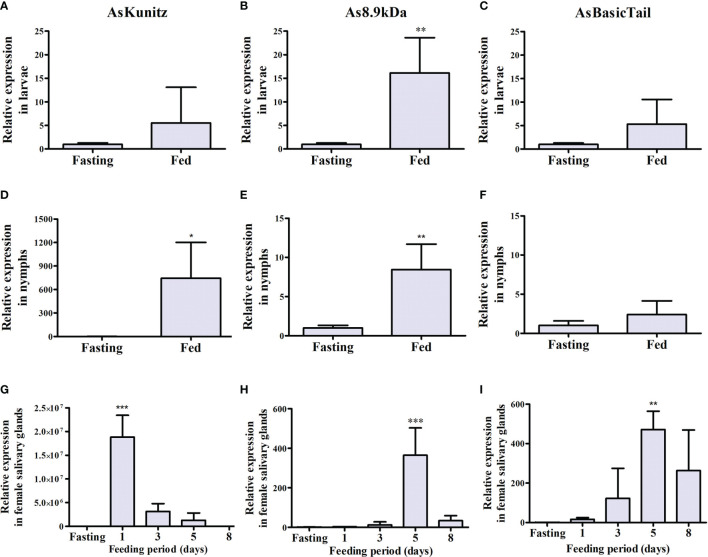
Relative messenger RNA (mRNA) levels of AsKunitz, As8.9kDa, and AsBasicTail in Amblyomma sculptum instars during feeding. Measurements were performed using quantitative polymerase chain reaction in whole body for larvae (A–C) and nymphs (D–F) and in the salivary glands for females (G–I). Feeding = 3 days of feeding. Statistical analysis: (A–F)—t-test, (G–I)—ANOVA–Dunnett, *p < 0.05, **p < 0.01, and ***p < 0.001 indicate difference from the fasting group. Data is shown as mean ± standard deviation (SD).